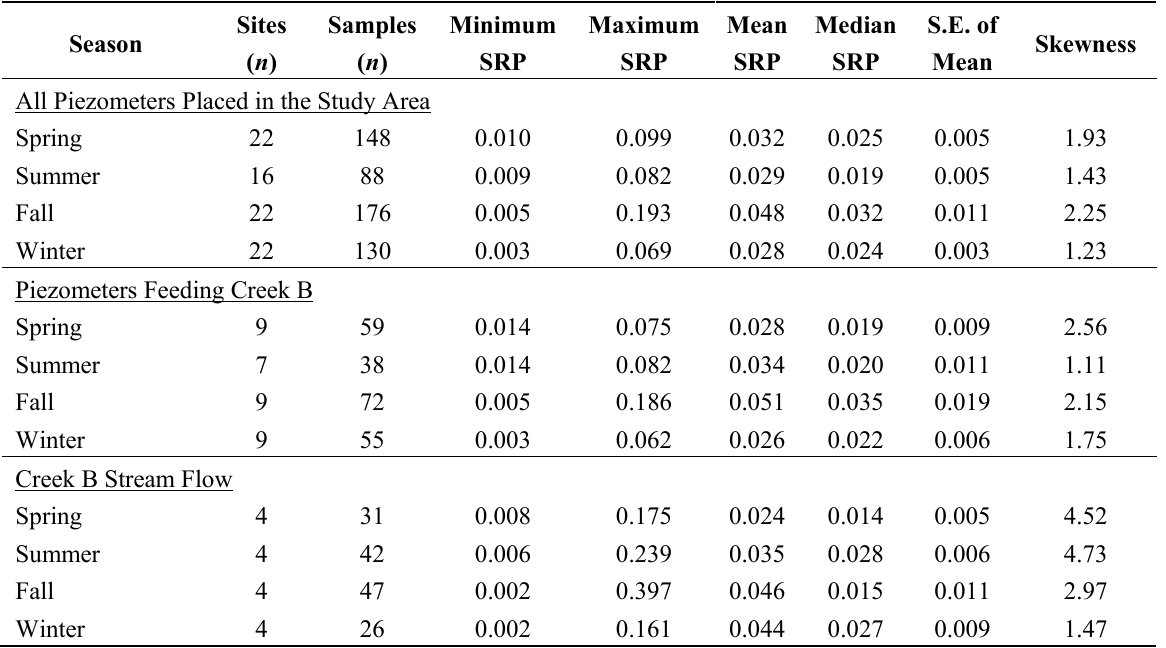
Table 1. Descriptive statistics of SRP values for all piezometers placed in the study area (including those that were not used for this paper), and those feeding Creek B, and Creek B stream flow. All SRP data in mg L − 1